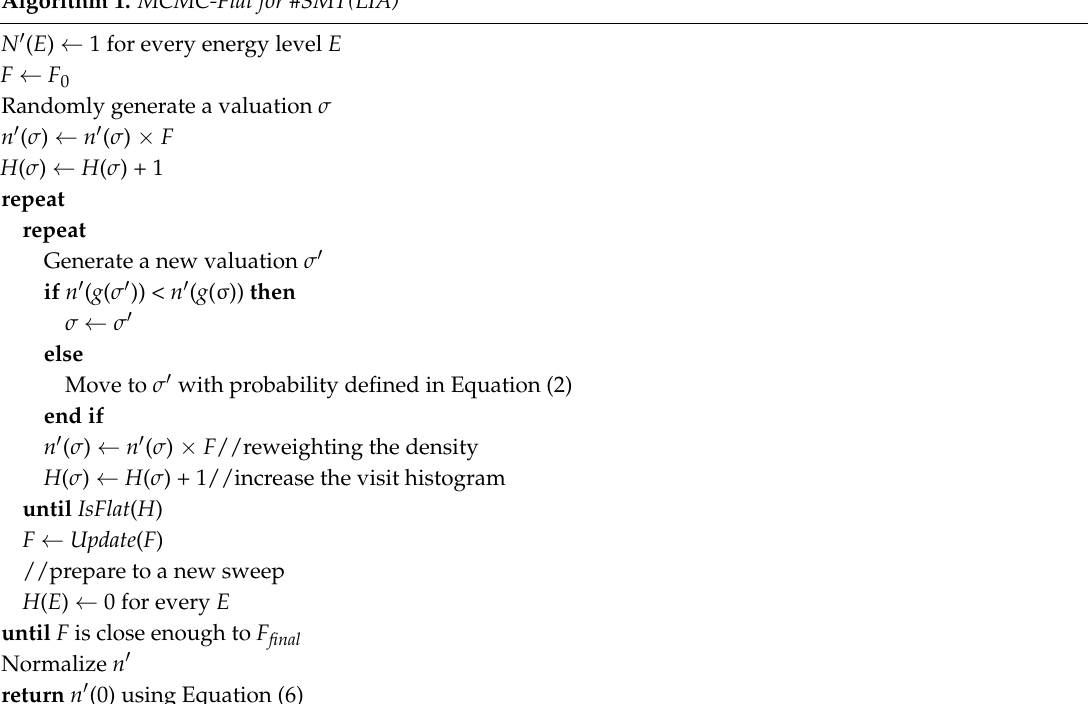
Algorithm 1. MCMC-Flat for